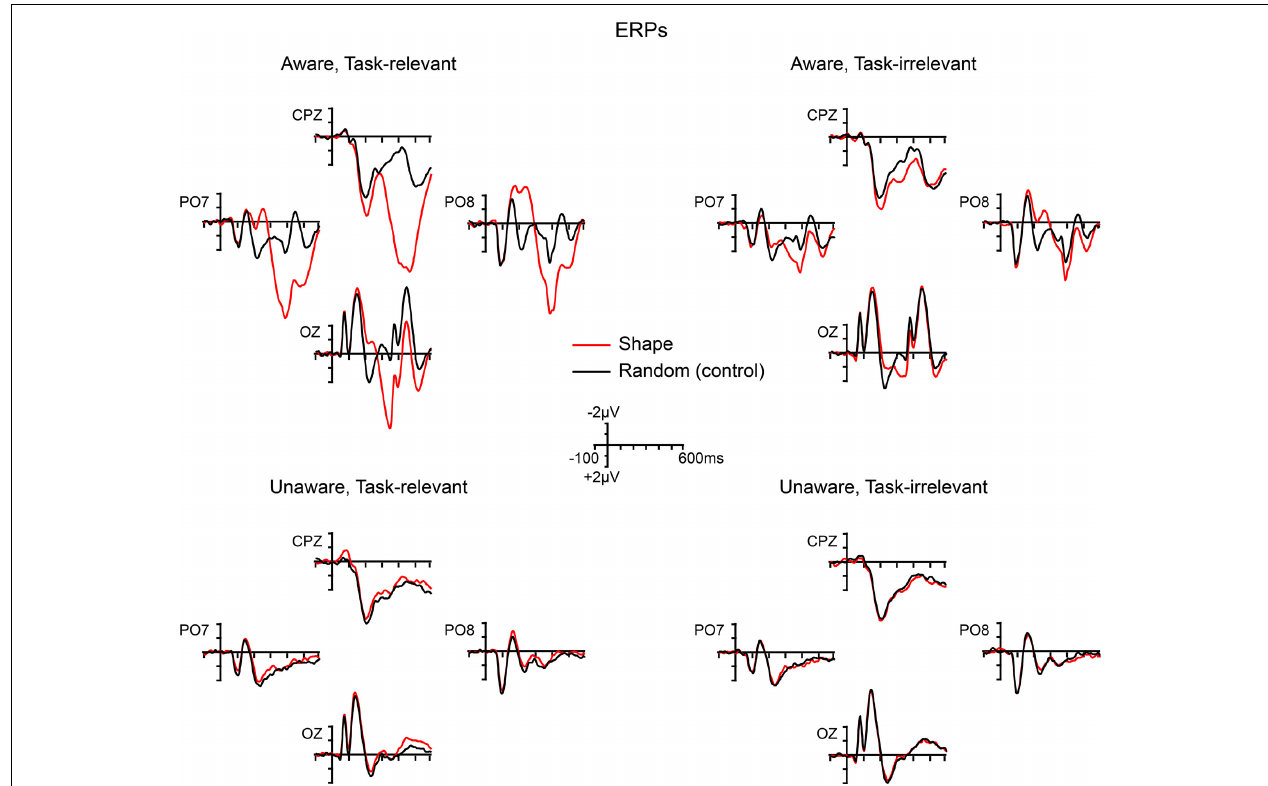
FIGURE 5 | Grand-averaged ERPs elicited by shape (square) and random (control) stimuli across the four main experimental